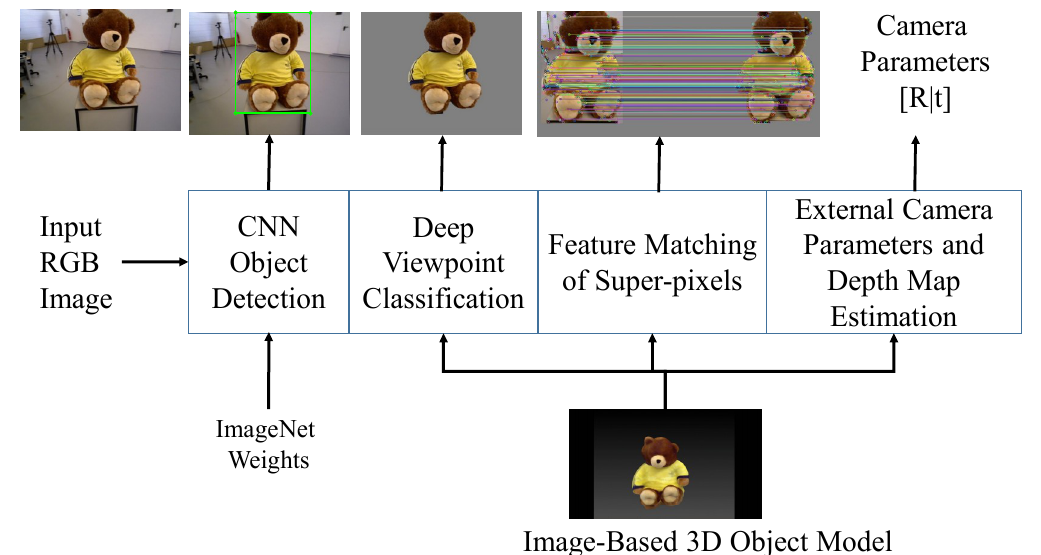
Figure 6. Model-based estimation of the external camera parameters of an object in a single RGB image.